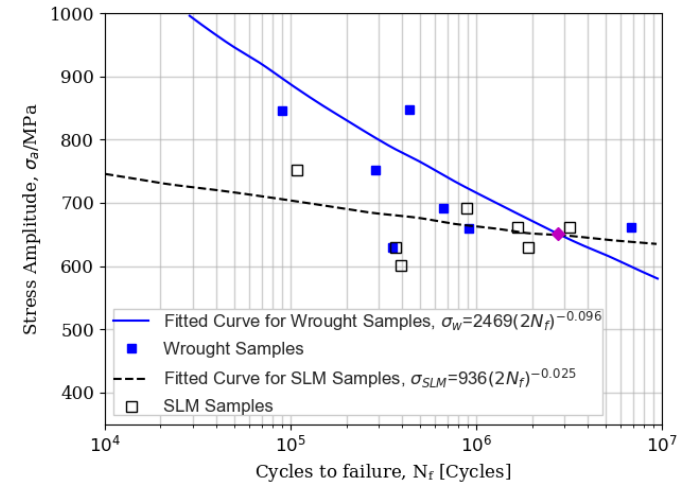
Figure 30: S-N curves wrought and SLM IN718 in push-pull mode tests [73].